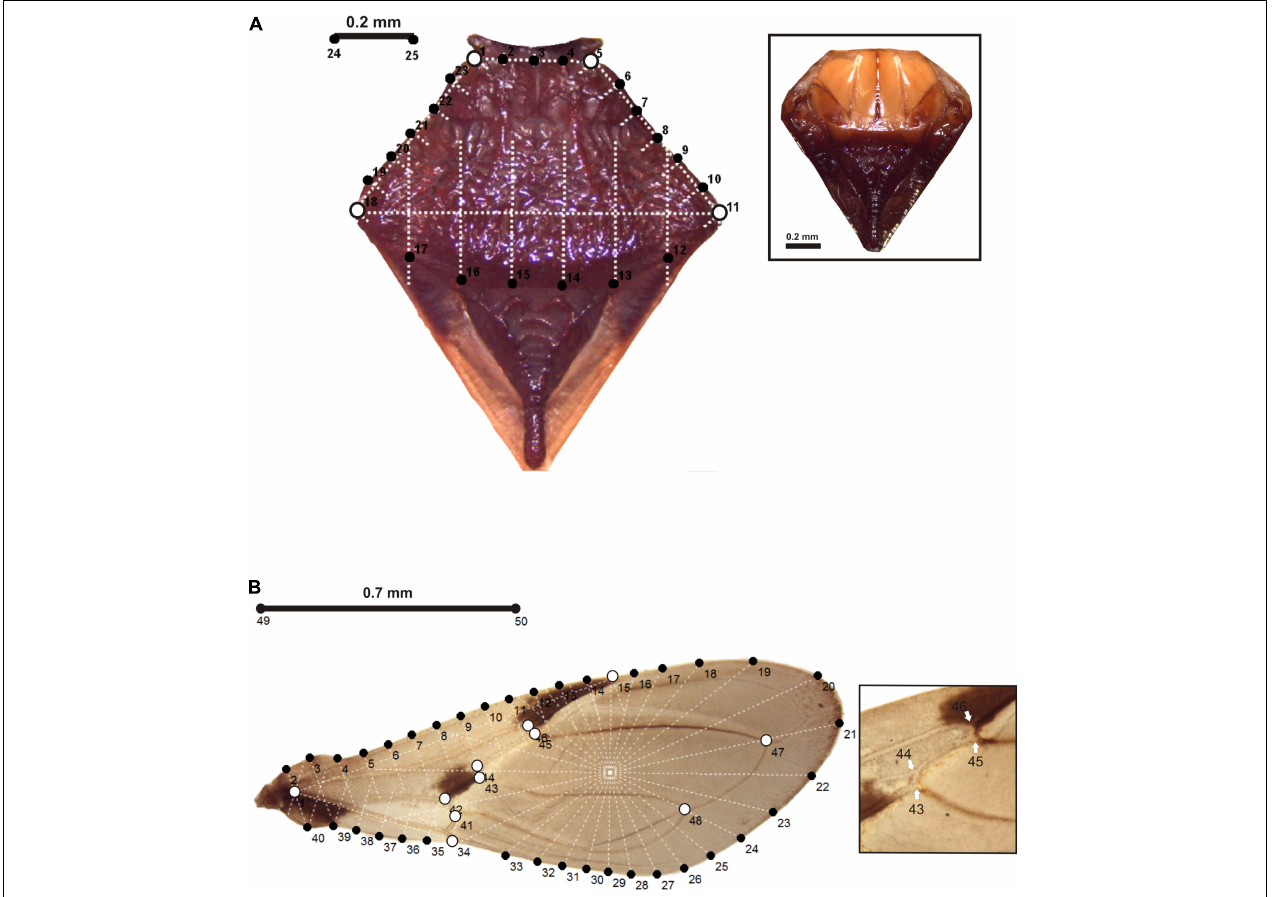
FIGURE 2 | Landmarks used to capture the configuration of T. dimidiata shape: (A) thorax (Landmarks, LM = 4 and Semilandmarks, SML = 19; right, muscle mass in thorax); and, (B) wing (Landmarks, LM = 11 and Semilandmarks, SML = 37). White dots are LM, and black dots are SLM.